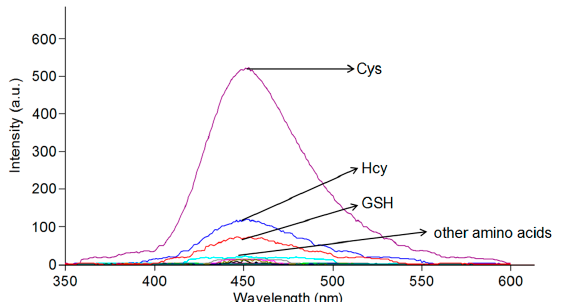
Figure 2. Fluorescence intensity of the probe (10 μ M) in the presence of different compounds (50 equiv.); each reaction was in buffered solution (PBS:DMSO = 6:4, pH = 7.4) at room temperature. λ ex = 325 nm.